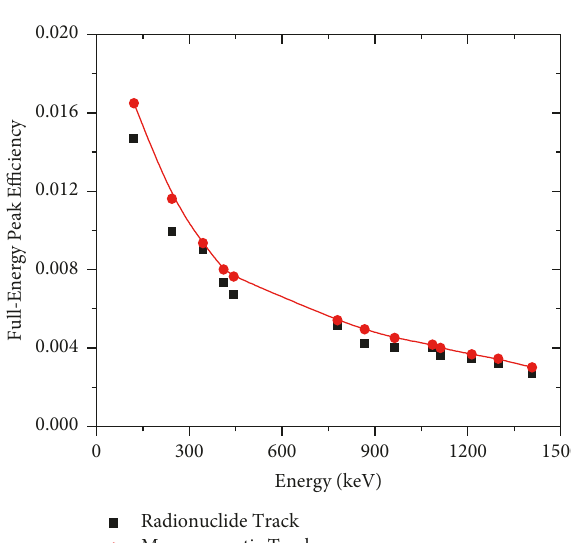
Figure 7: Comparison of 152 Eu full-energy peak efficiency calibration curve using two different tracks using cylindrical source of 1000mL put at the top of the